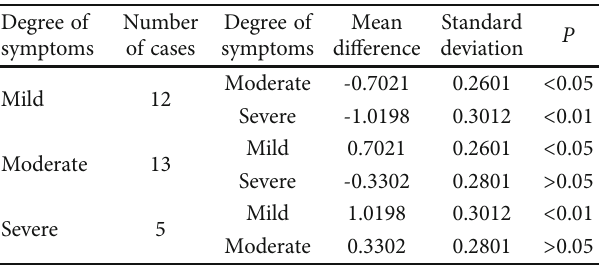
Figure 7: Comparison of the mean score of SCL between patients with chronic prostatitis and healthy controls (2). Table 4: Comparison of SCL positive items with di ff erent severity of clinical